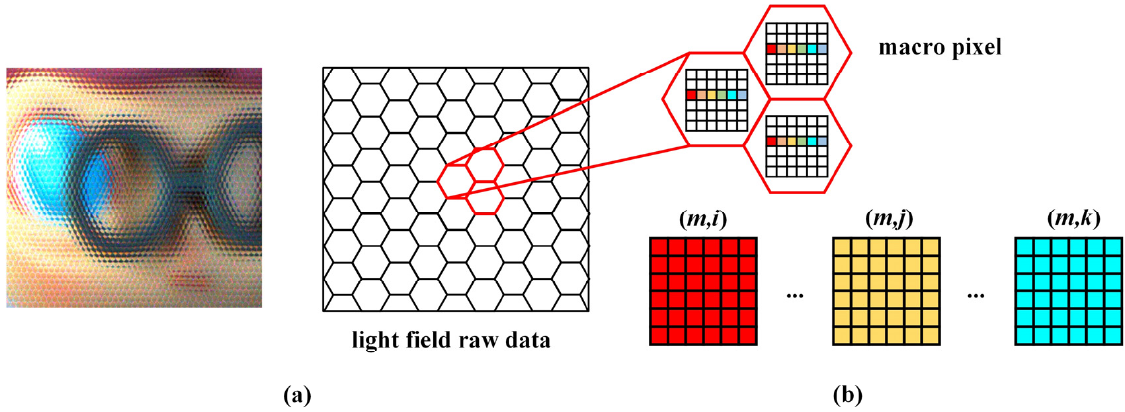
Figure 4. Sub-aperture imaging principle. ( a ) Light field image raw data; ( b ) Sub-aperture image extraction method.